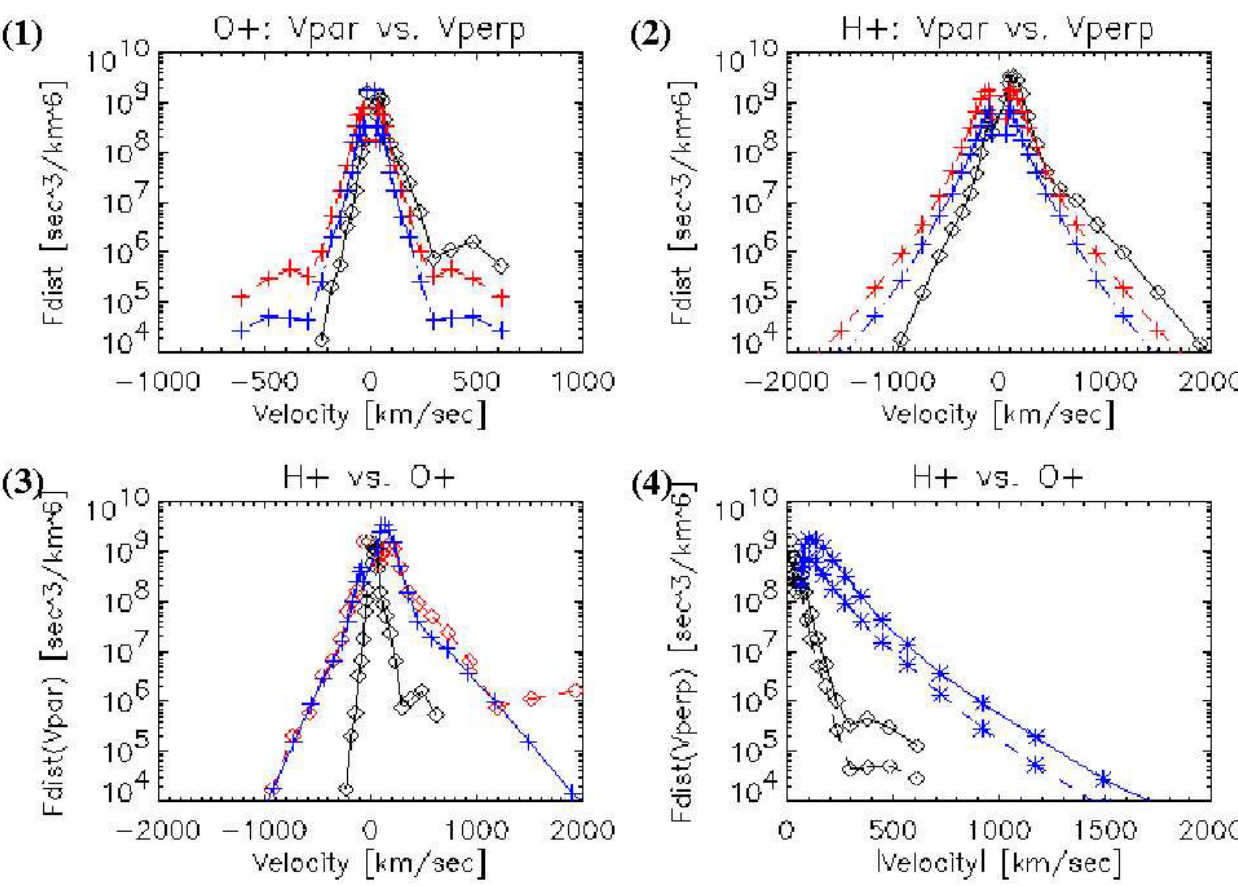
Fig. 7. The distribution functions at 19:48:33 UT on 13 February 2001, observed by the Cluster S/C-1. The construction of the figure is the same as that of Figure 4. These distribution functions are considered to be observed in the dayside